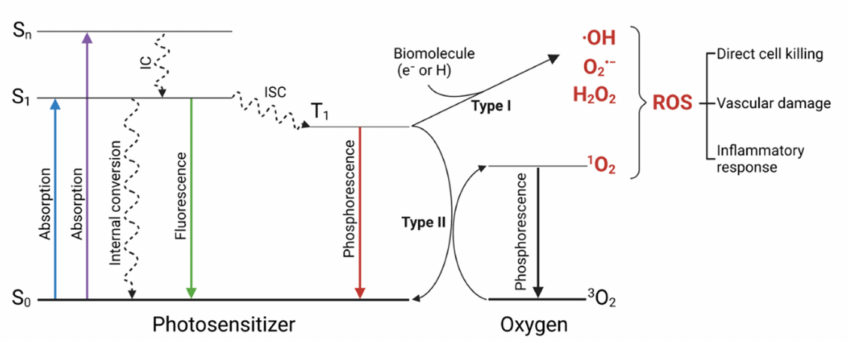
Figure 1. Jablonski diagram of photosensitizer (PS) excited states showing the photochemical mecha- nisms operating in photodynamic anticancer